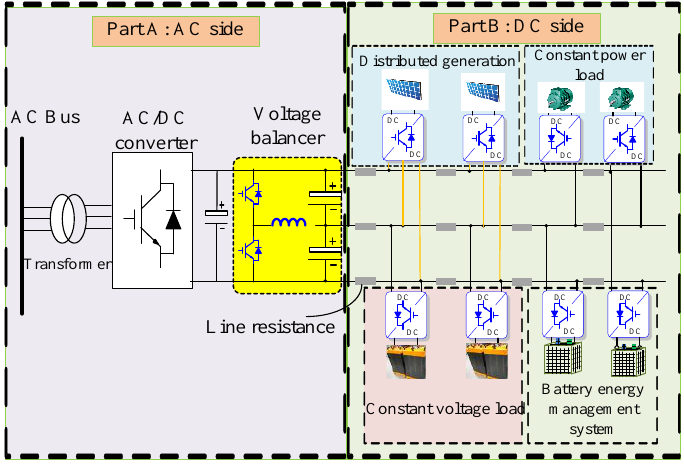
Figure 2. Configuration of the radial multi-node DC distribution network with voltage balancers.